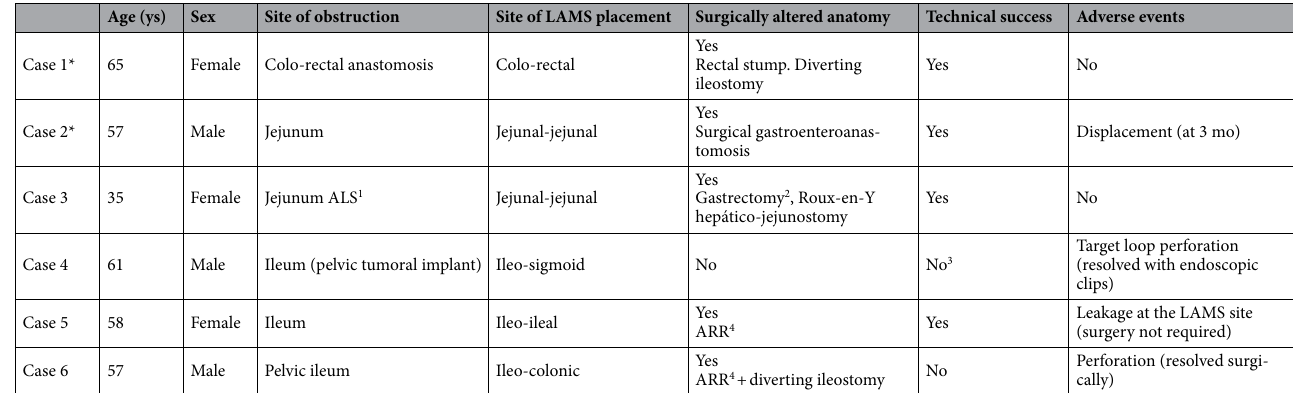
Table 1. Characteristics of patients undergoing EUS-guided anastomosis without involvement of the gastric wall. 1. Afferent loop syndrome. 2. Patient with diffuse gastric cancer. 3. The goal was to create an ileo- sigmoidostomy. Although the LAMS was released without incident, the punctured target loop turned out to be the jejunum instead of the ileum. Therefore, a jejuno-sigmoidostomy was created. 4. ARR Anterior resection of the rectum. *These are the two patients described in the text, in which the long-term permeability of the anastomosis was confirmed once the LAMS was